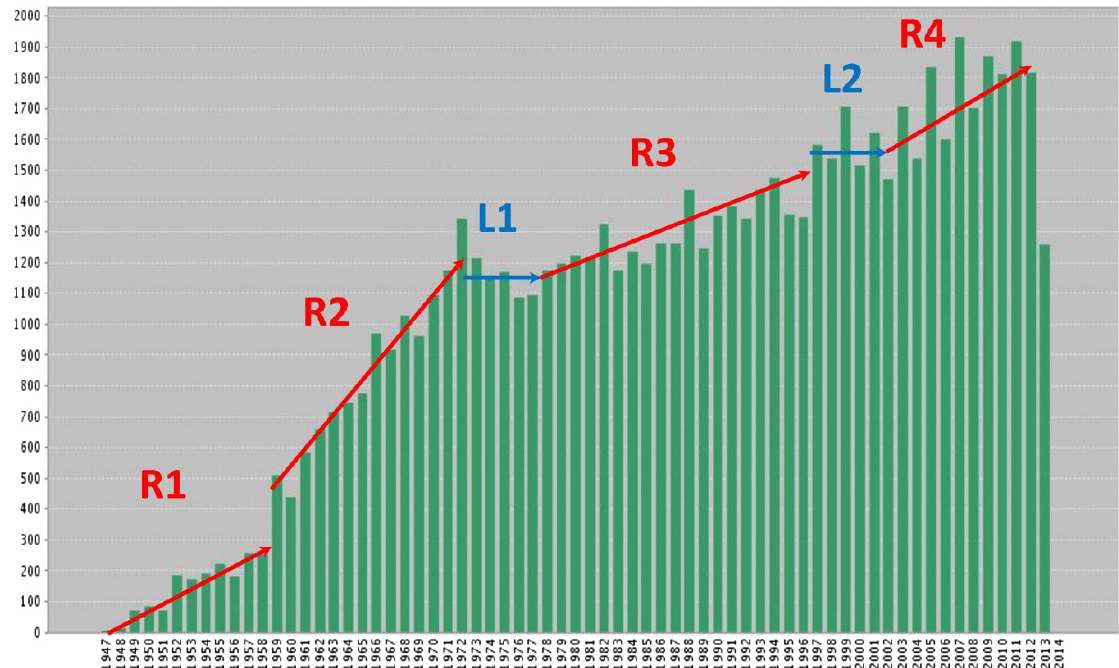
Fig. 2. The annual citations of publications of Britton Chance from 1947 – 2013. Graph reproduced from ISI Citation Indexes (accessed in April, 2013 excluding meeting abstracts) with modi¯cations. R: rising phase; L: leveling phase as described in the